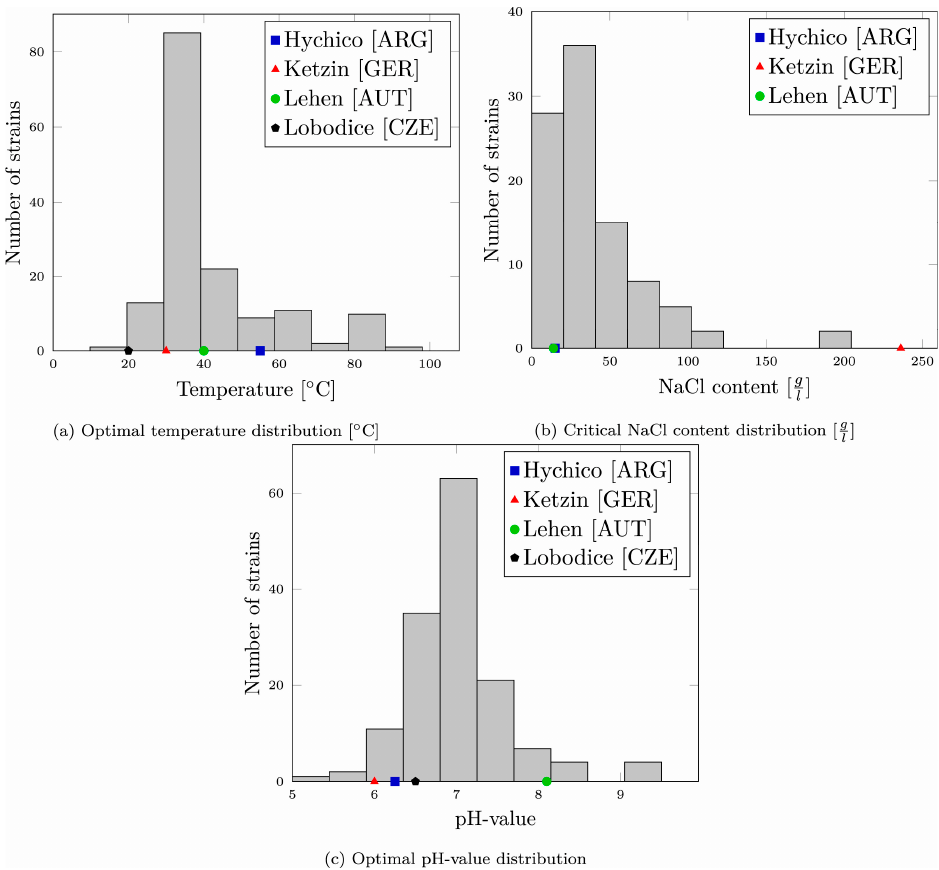
Figure 3. Effects of ( a ) temperature, ( b ) salinity, and ( c ) pH on the activity of methanogens [56].